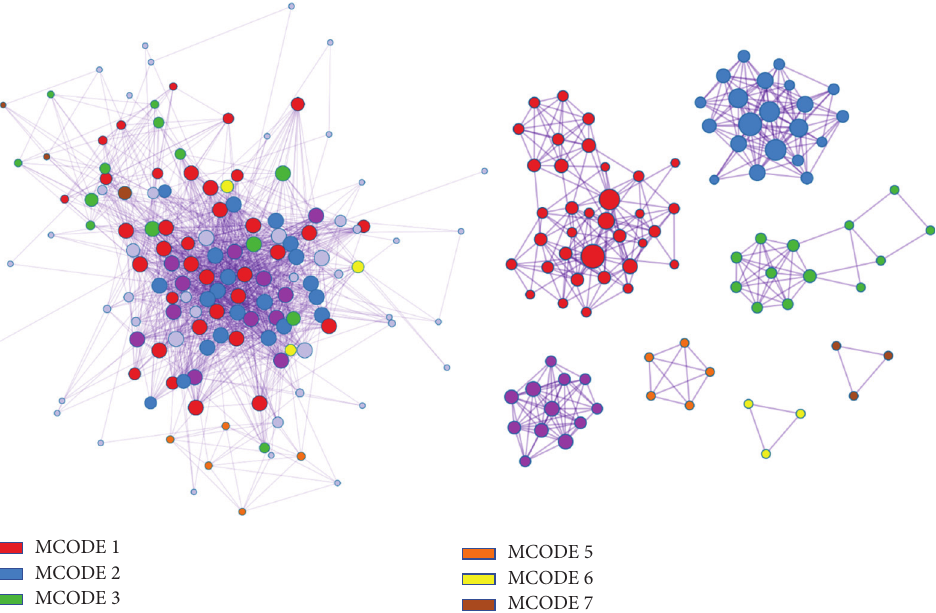
Figure 4: Protein-protein interaction network.